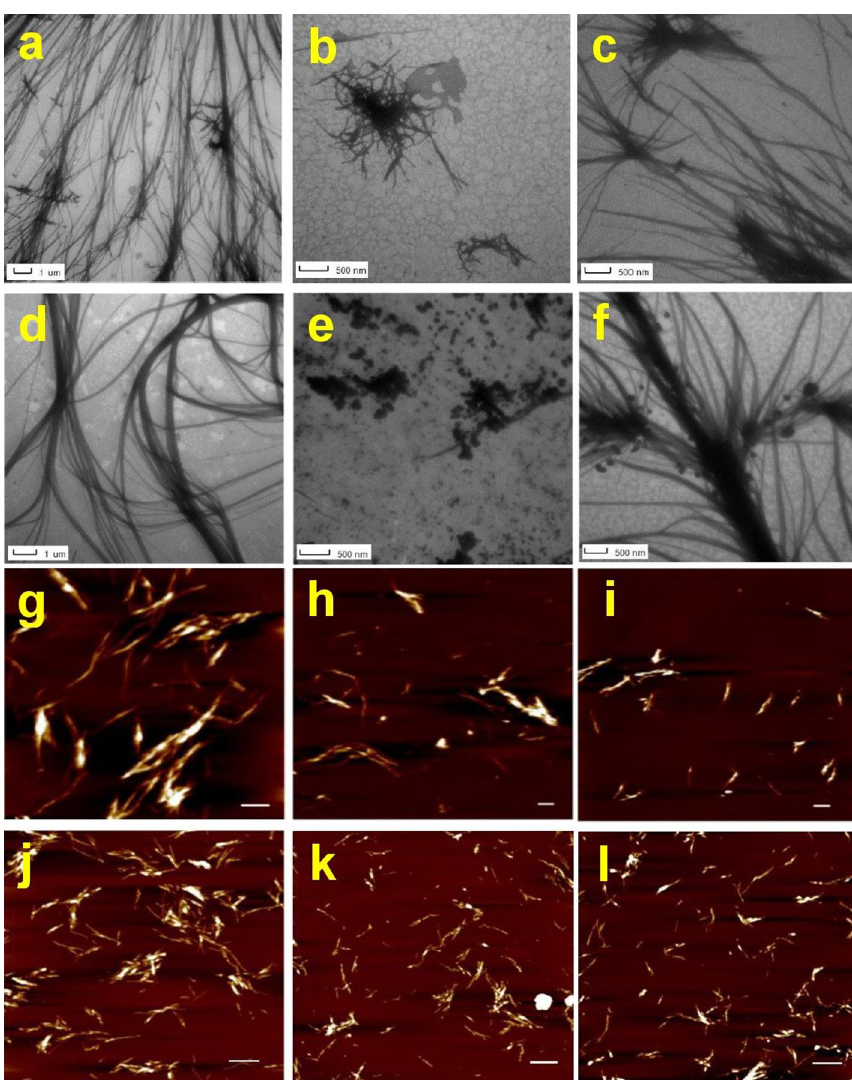
Figure 6. Microscopic determination of anti-amyloidogenic activity of CZ particles using TEM ( a – f ) and AFM ( g – l ) techniques. Disassembly effect of CZ particles was studied using lysozyme amyloid fibrils incubated alone (control) ( a ) and in the presence of MCZ ( b ), and 30 µm synthetic zeolite particles ( c ). Insulin amyloid fibrils alone (control) ( g ); incubated in the presence of 3 µm CZ ( h ) and 20 µm CZ particles ( i ) at the fibrils to nanoparticle concentration ratio of 1:5 (mg/mg). Inhibitory effect of CZ particles on insulin amyloid fibrils formed alone ( d ); in the presence of MCZ ( e ) and 30 µm synthetic zeolite particles ( f ). Lysozyme amyloid fibrils formed alone (control) ( j ) and in the presence of 3 µm CZ ( k ) and 20 µm CZ particles ( l ) at the fibrils to CZ particle concentration ratio of 1:5 (mg/mg). The data analyses were performed using NanoScope Analysis 1.20 software. White scale bars represent 1